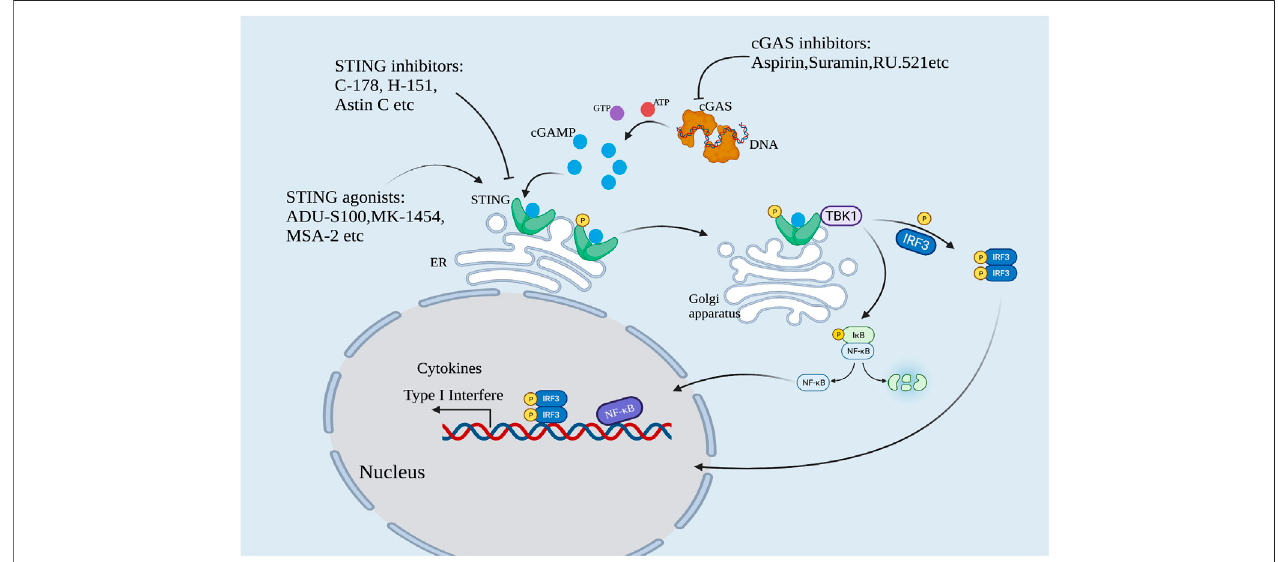
FIGURE 1 | The cGAS-STING pathway. cGAS is activated by sensing cytoplasmic DNA. Activated cGAS catalyzes the formation of cGAMP. cGAMP activates STING protein, and activated STING recruits TBK1 and phosphorylates IRF3. Meanwhile, STING activated IKK kinase and phosphorylated I κ B, leading to the release of NF- κ B. Phosphorylated IRF3 formed dimer and translocated with NF- κ B into the nucleus to synergistically induce the expression of IFN-I and various in fl ammatory factors. This pathway can be regulated by cGAS and STING modulators.